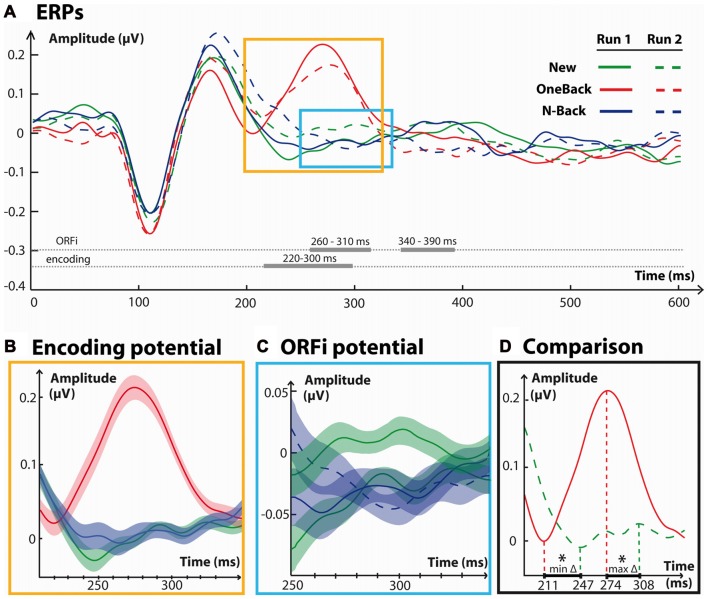
Frontal waveform analysis. (A) Waveforms from a cluster of eight neighboring frontal electrodes averaged over 600 ms for each condition. Traces in a straight line refer to stimuli from run 1, while traces in a dashed line refer to run 2. Horizontally, in thick gray lines are indicated the time windows with significant effects between stimuli of each condition. Time windows with effects specific to the Encoding (220–300 ms) and ORFi (260–310 ms) potentials are detailed in the colored boxes. (B) Event related potentials (ERPs) in response to New1, OneBack1 and N-Back1 stimuli. (C) ERPs in response to New1, New2, N-Back1 and N-Back2 stimuli (C) for the period of significant interaction between their respective amplitudes. (D) Comparison of the positive potentials in ERPs from OneBack1 and New2 stimuli for the period of time identified in (B,C). The red dashed lines indicate the time points of average minimum and maximum amplitude. The lagging time period between minima and maxima was statistically significant, as indicated asterisks (*), and is projected in bold on the x axis. The Encoding potential precedes ORFi potential by approximately 35 ms.